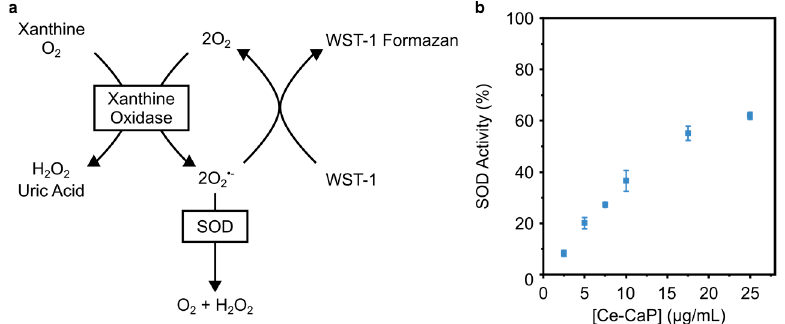
Figure 4. SOD-like activity of Ce-CaP NPs. ( a ) Schematic of the assay used to quantify the SOD-like activity of Ce-CaP NPs. ( b ) SOD-like activity of Ce-CaP NPs as a function of their concentration. Ce-CaP NPs were added to a solution containing xanthine oxidase and tetrazolium salt; the mixture was incubated at 37 °C for 20 min, after which the absorbance at 450 nm was recorded. Data points are represented as mean ± s.d. (N = 3 independent batches, n = 3 technical replicates).